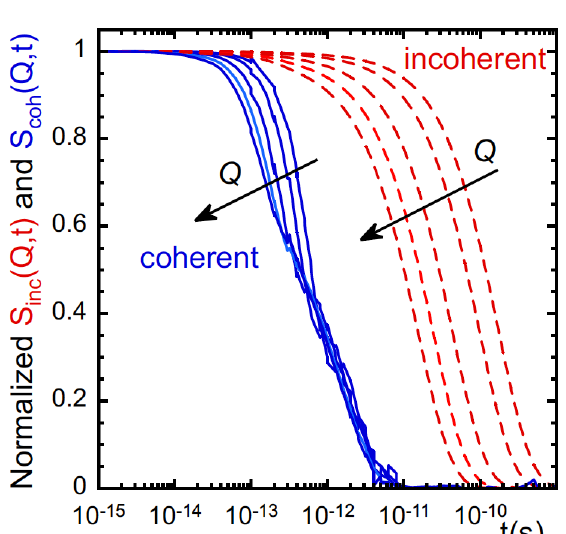
Fig. 2. Normalized coherent and incoherent dynamic structure factors at different Q -values [ Q = 0.15 Å 34 ; Q = 0.2 Å 34 ; 𝑄 = 0.3 Å 34 ; 𝑄 = 0.5 Å 34 ] calculated from the simulations for D 0 O at